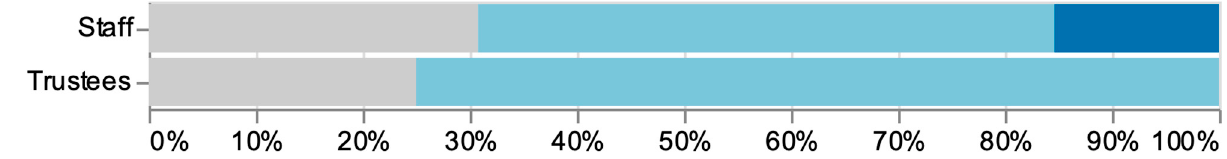
Figure 8. “I believe Lancaster Seminary should improve the way it meets the needs of bivocational students through academic curriculum”. (Q18 for staff and trustees). 0% strongly disagree; 0% disagree; 29% neutral; 62% agree; 10% strongly agree.